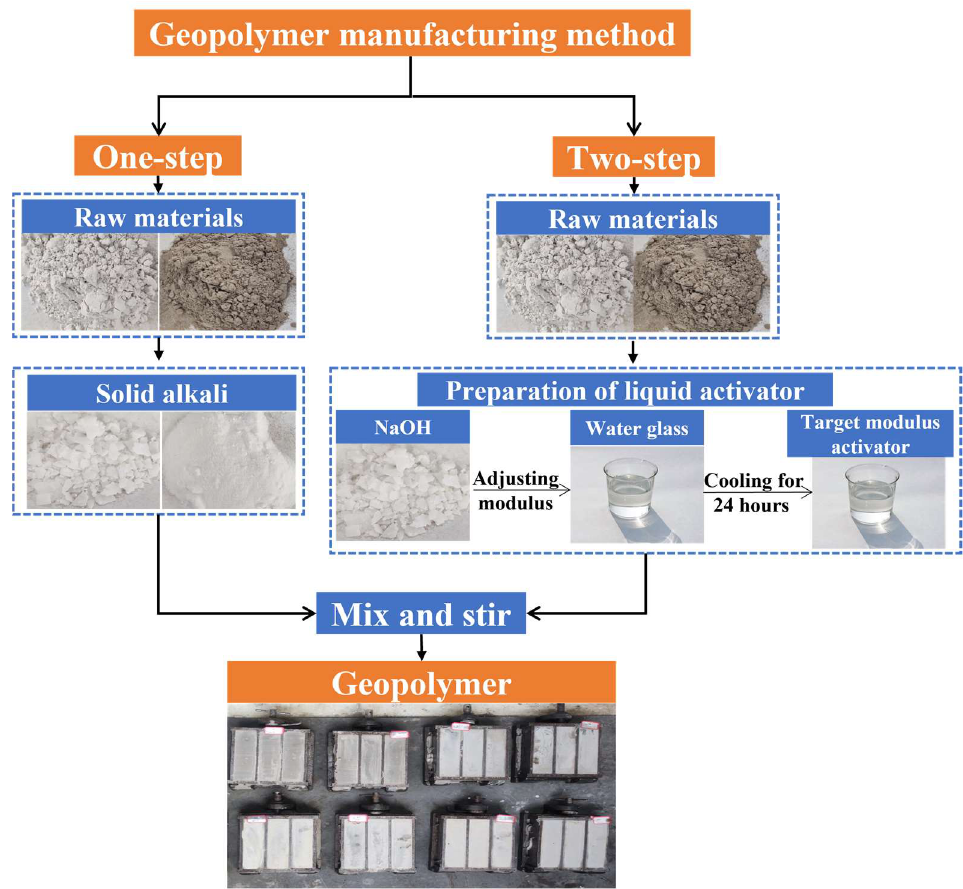
Figure 3. Preparation method of geopolymer.